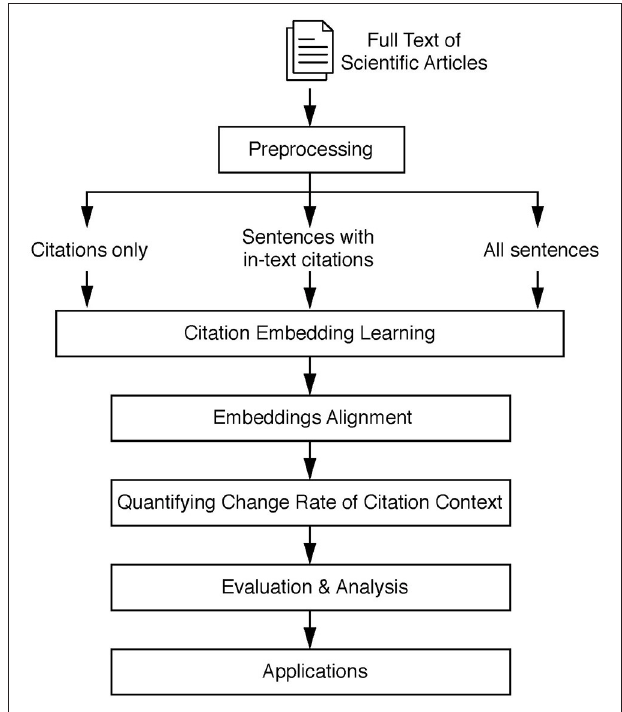
FIGURE 2 | An overview of